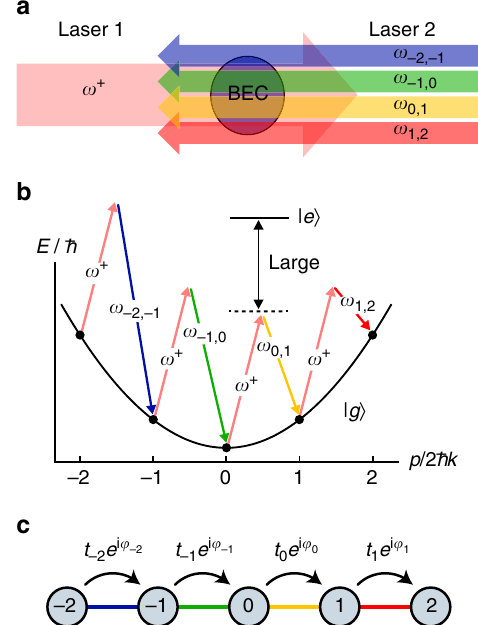
Fig. 1 Spectroscopic control of lattice dynamics. a An atomic Bose-Einstein condensate ( BEC ) illuminated by two counter-propagating lasers, one of which (Laser 2) contains multiple discrete spectral components. b Energy diagram of free-particle-like momentum states coupled by counter- propagating, far-detuned Bragg laser fi elds (characterised by nearly identical wavevectors k ). The spectral components ω j , j +1 of laser 2 are used to separately address individual Bragg transitions between momentum states j and j + 1. c Cartoon depiction of the effective tight-binding lattice model when all two-photon Bragg resonance conditions are matched, resulting in a fl at site-energy landscape. The amplitudes and phases of the tunnelling elements t j e i φ j are independently controlled through the spectral components of laser 2. The lattice site energies ε j may also be independently controlled through the detunings from two-photon Bragg